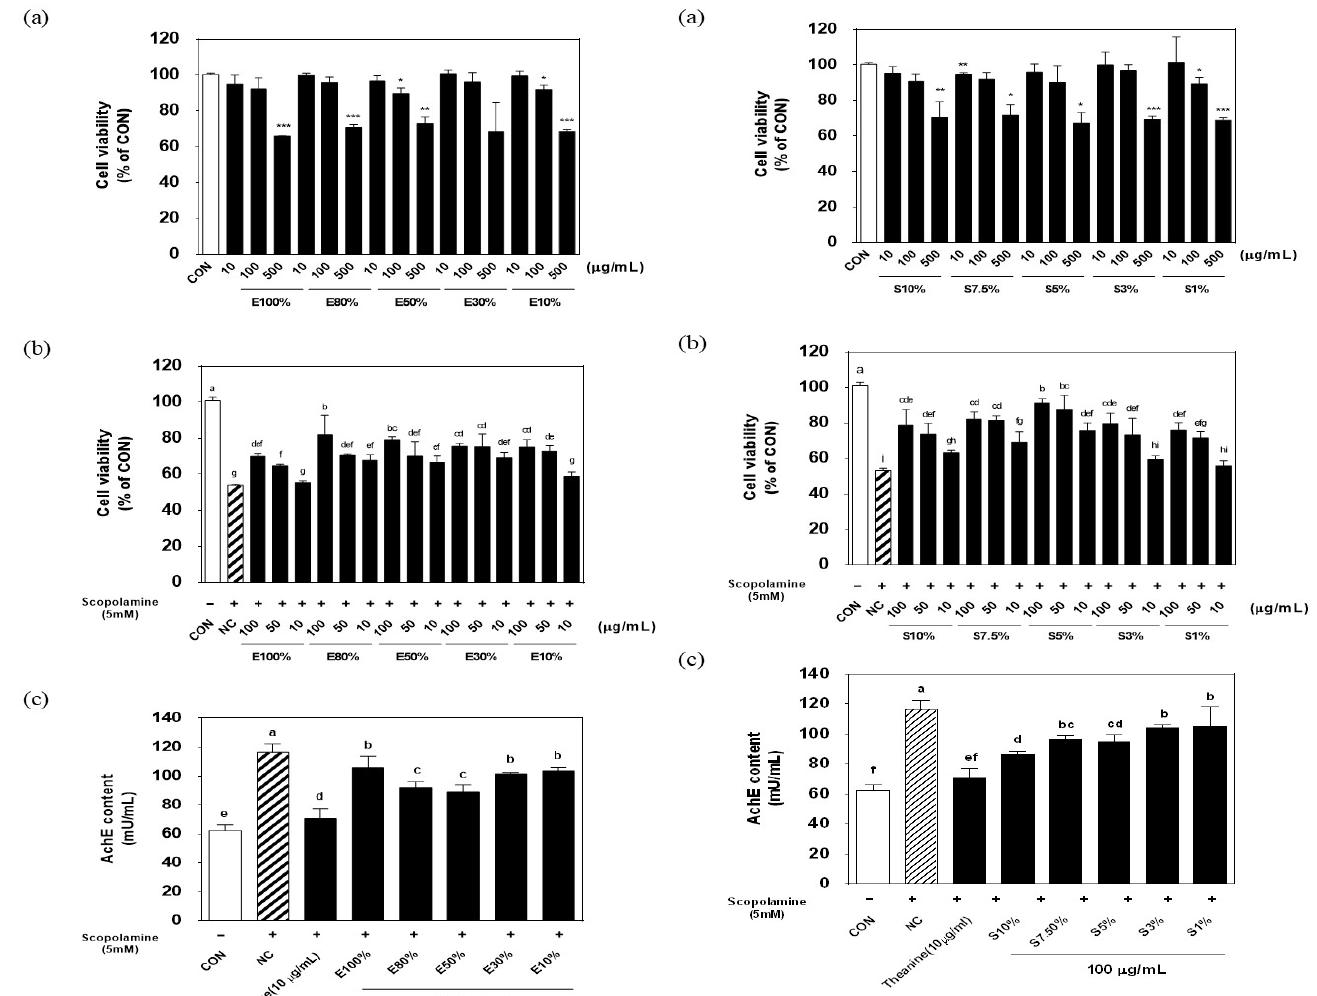
Fig. 3: Neuroprotective effects of yuzu extracts by extraction condition on human neuroblastoma cells (SH-SY5Y). ( a ) Cell toxicity; ( b ) cell viability after scopolamine treatment; ( c ) acetylcholinesterase con- tent (AChE) by ELISA. Data are shown as mean ± SD. Significance levels (*p < 0.05, **p < 0.01, ***p < 0.001) compared to respective parameter value of control group. Different letters above the bar rep- resent a significant difference between groups by Duncan’s multiple range test (p < 0.05). “E” denotes ethanol concentration (% v/v) in extraction solvents with 5% yuzu